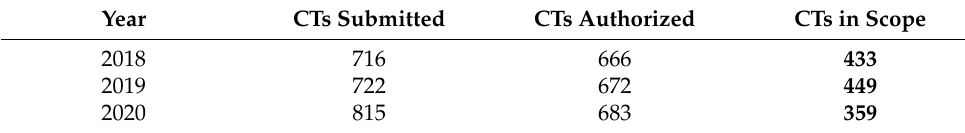
Table 1. CTs submitted, authorized, and within the scope of this